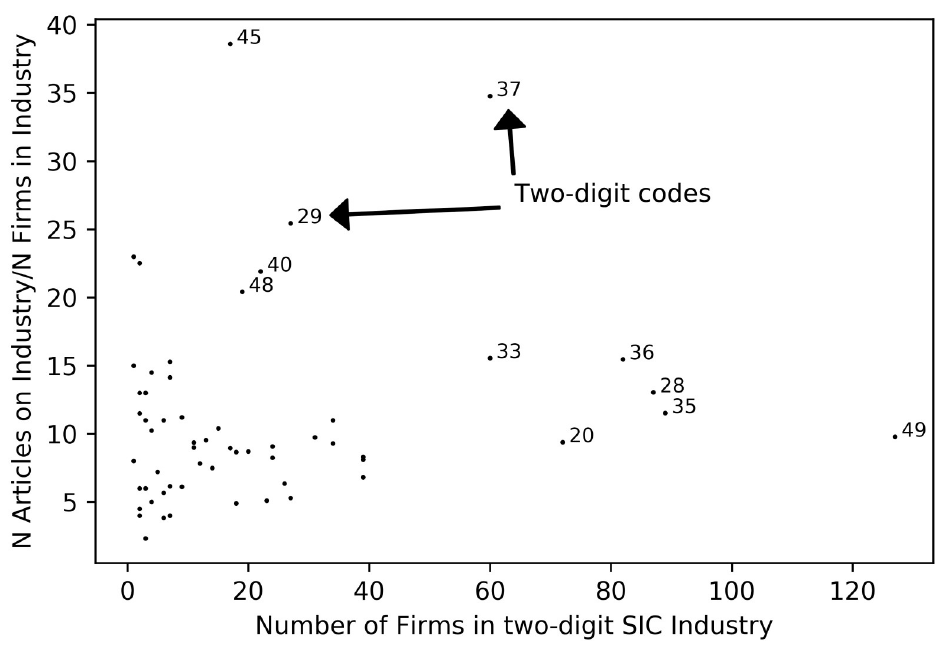
Fig 2. Number of firms in two-digit SIC industry. Number of firms in two-digit SIC industry are plotted against the number articles published in WSJ divided by number of firms in the industry.